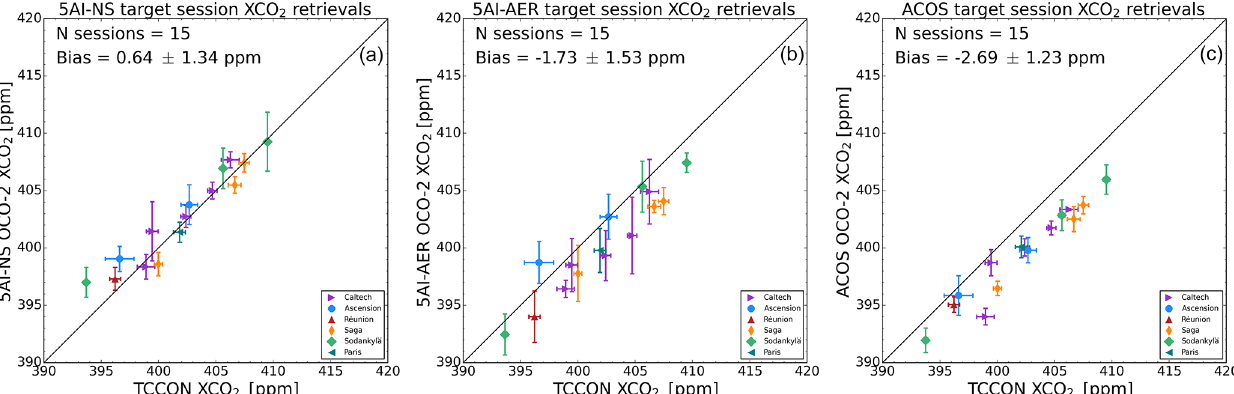
Figure 9. The 5AI-NS (a) , 5AI-AER (b) , and raw ACOS B8r (c) OCO-2 target X CO product. Individual sounding results are averaged for every target session. Markers show the session average for OCO-2 and TCCON X CO and error bars show the standard